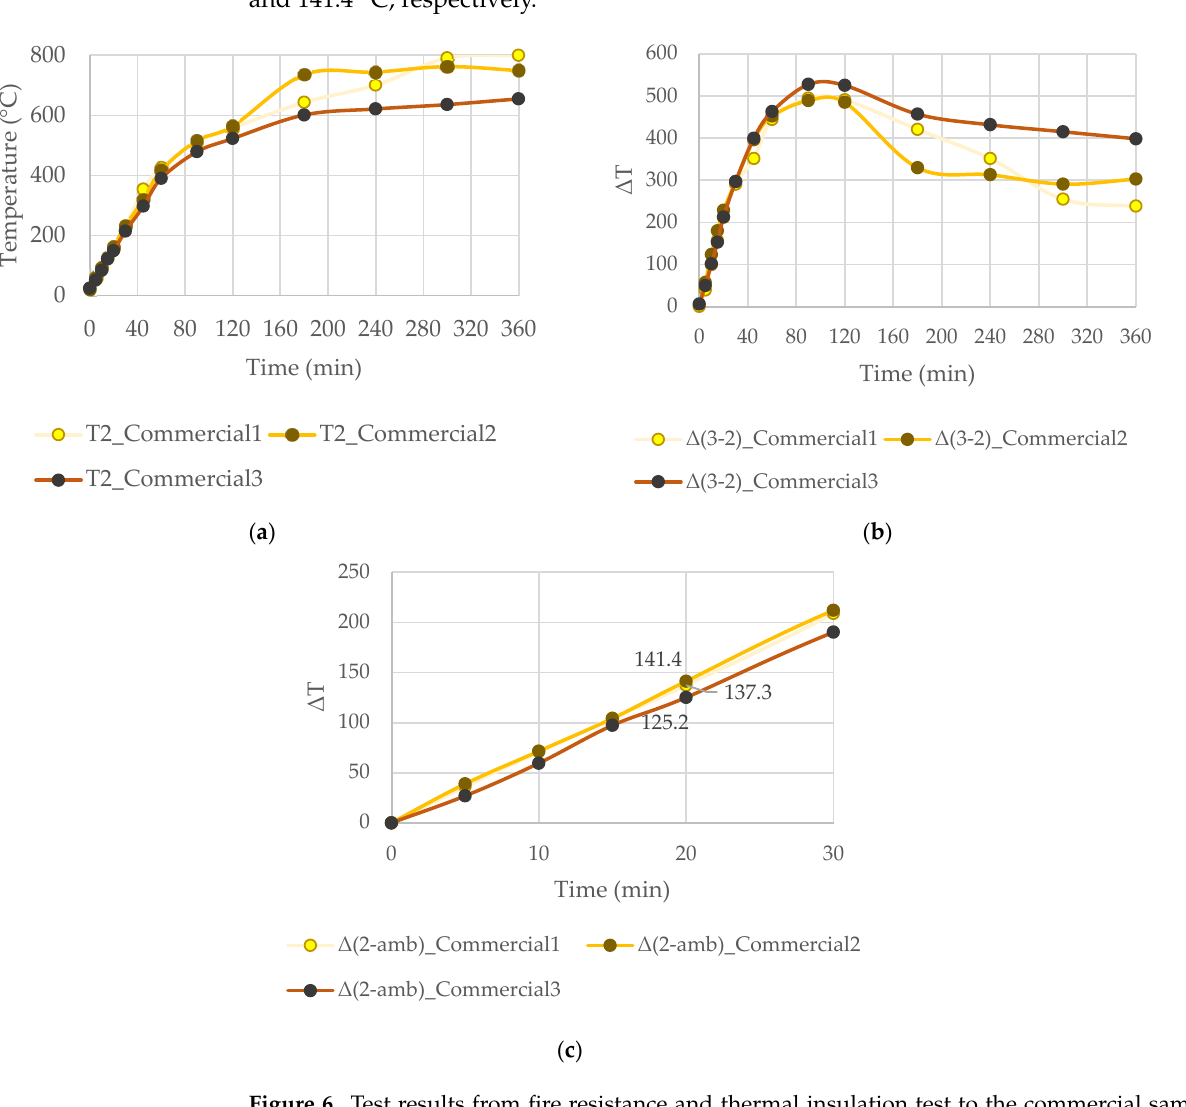
Figure 6. Test results from fire resistance and thermal insulation test to the commercial samples (Commercial1, Commercial2, and Commercial3): ( a ) Outer surface temperature; ( b ) Thermal capacity (temperature difference between outer and inner surface); ( c ) Thermal insulation (temperature difference between ambient and outer surface) characterized according to the standard EN 13501-2 [11].